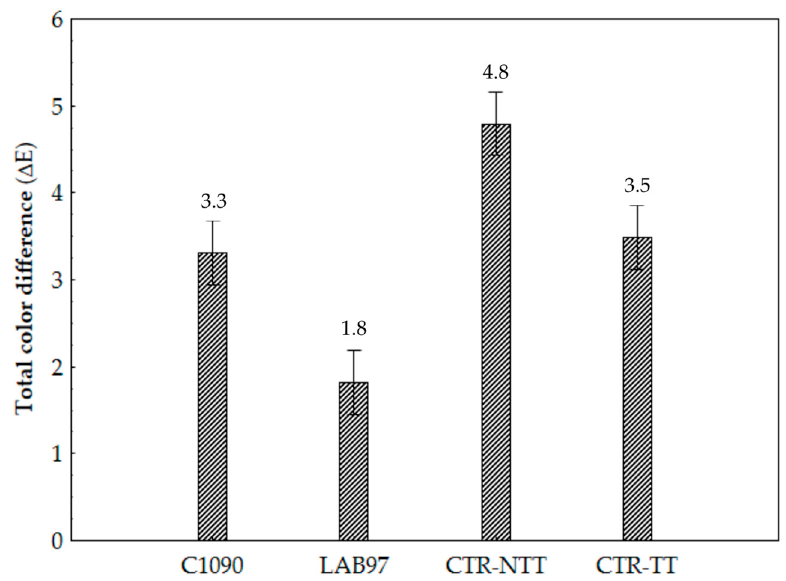
Figure 5. The average Δ E values of the immature tomato pulp samples that were inoculated with single LAB starter cultures (LAB97 and C1090) and non-inoculated samples (CTR-NTT and CTR-TT) after 14-day storage. Bars represent the confidence intervals at 95%.